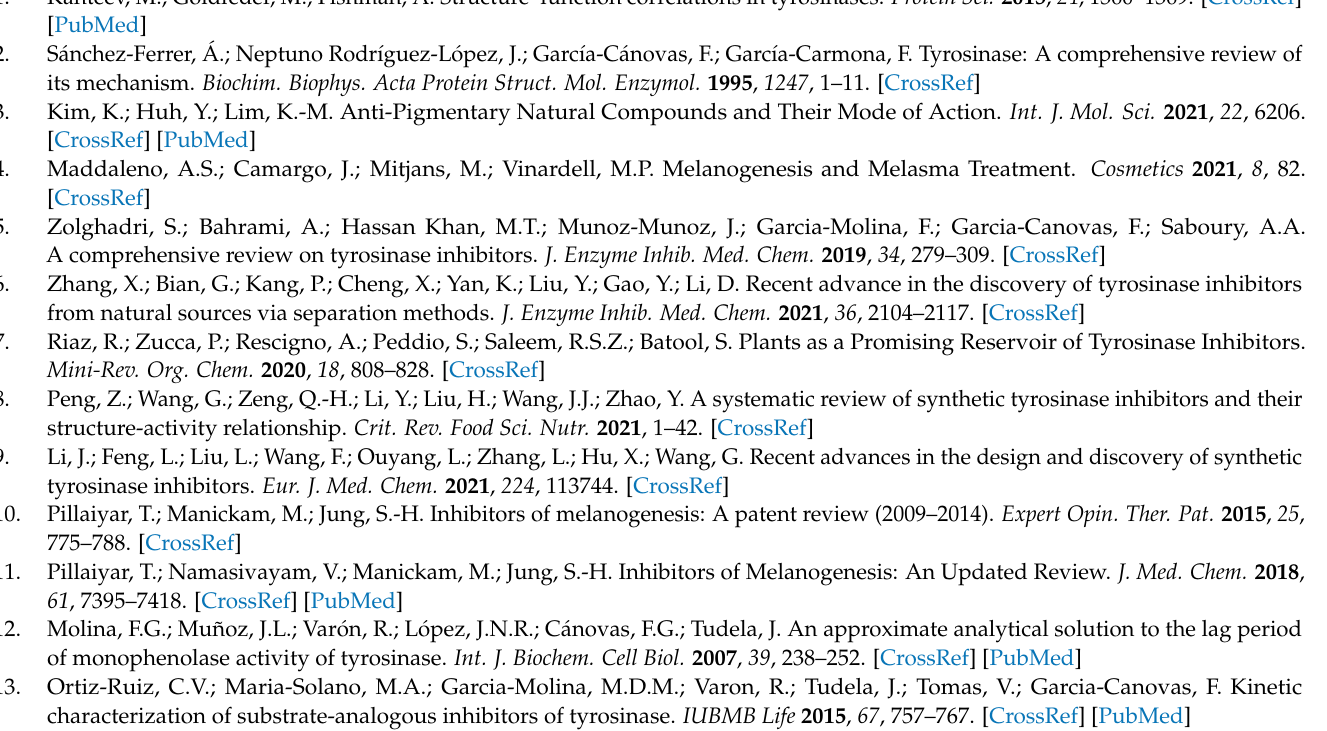
Table S4: Ligand-protein interactions observed in the docking conformations of the oxy and met forms of tyrosinase in the cases of competitive inhibition. Analysis of the interactions was carried out using PLIP